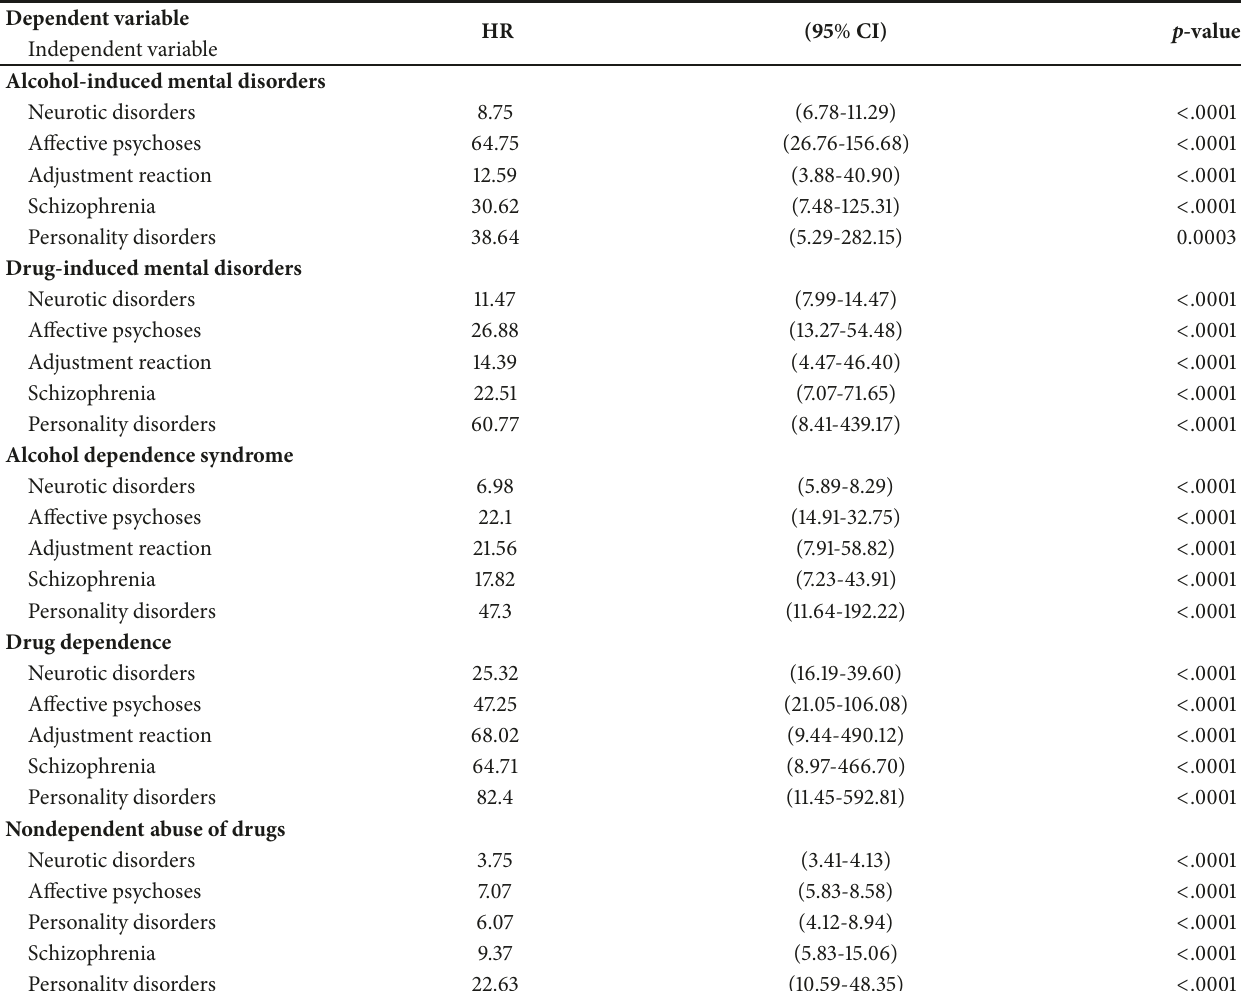
Table 5: Estimated hazard ratio of the subsequent onset of each subtype of SRDs for those with the selected mental disorders compared to those without, adjusted for age, gender, urban, and income